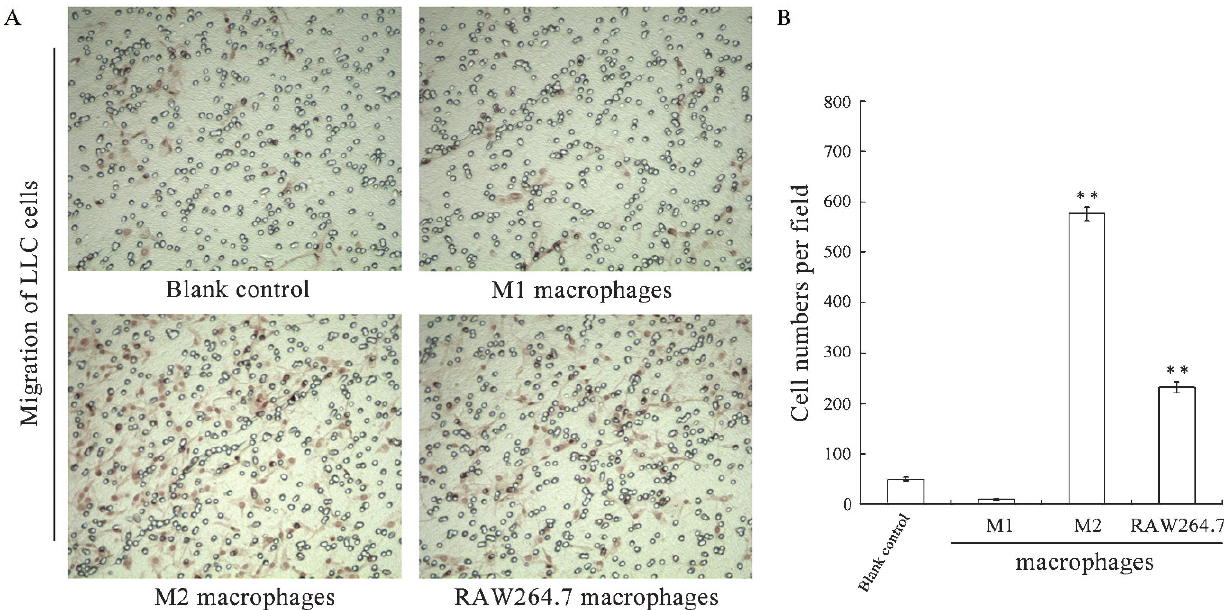
Figure 2 - Effect of activated macrophages on the migration of LLC cells. (A) Following the culture of a blank control or the addition of M1 macrophages, M2 macrophages or RAW264.7 macrophages for 24 h, invasive LLC cells on the outer surface of the upper chambers were stained with H&E (200 6 ). (B) Comparison to the penetrated cells. The data shown represent three experiments. ** p , 0.01 compared to the blank